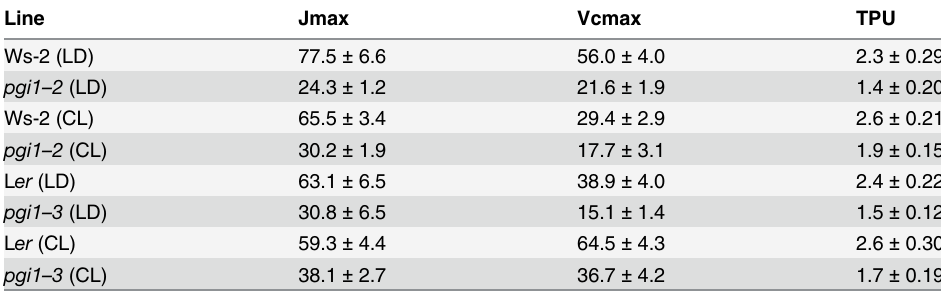
Table 1. Photosynthetic parameters of WT (Ws-2 and L er ), pgi1 – 2 and pgi1 – 3 source leaves. Plants were cultured under LD and CL conditions. Values represent the mean ± SE (n =